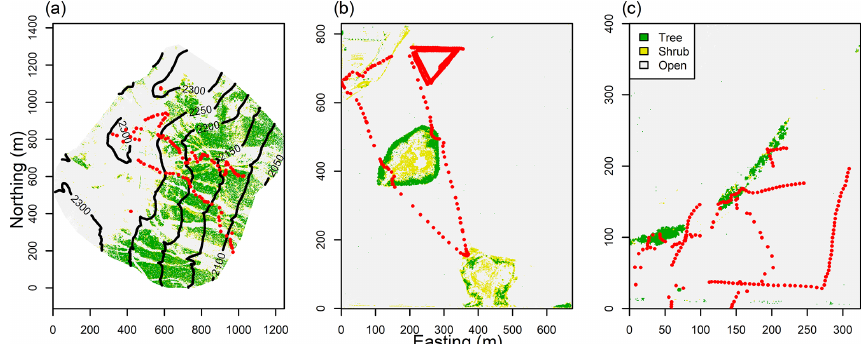
Figure 4. Fortress (a) , Rosthern (b) , and Clavet (c) study sites classified by vegetation height derived from snow-free (ground) UAV lidar into open ( < 0 . 5m), shrub ( > 0 . 5 and < 2m), and tree ( > 2m) domains. Red points identify locations of manual snow depth survey observations sampled over the course of the data collection campaign. Black lines in the Fortress map are 50m elevation contours.